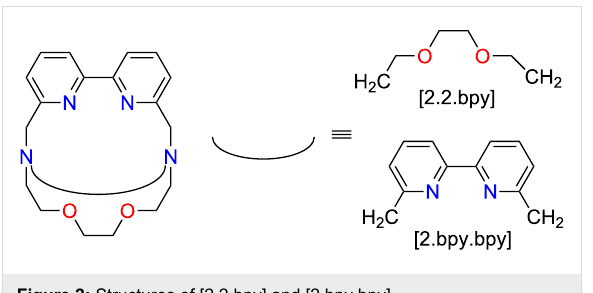
Figure 2: Structures of [2.2.bpy] and